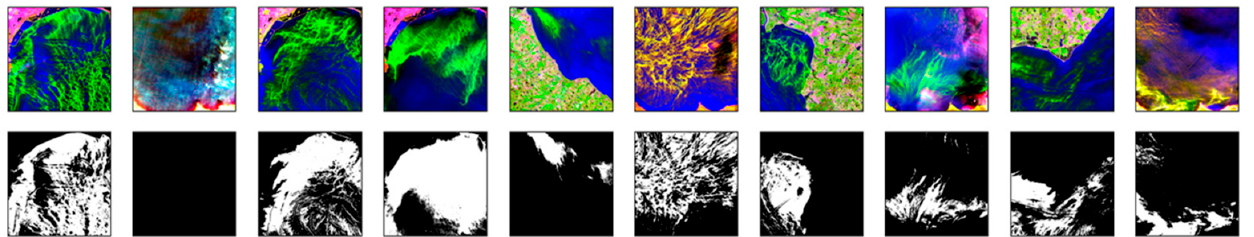
Figure 7. Statistics of “ground truth” results based on visual interpretation. ( a ) The best extraction threshold distribution of CyanoHABs in 110 images and ( b ) the change of CyanoHABs area with time between 2016 and 2020.